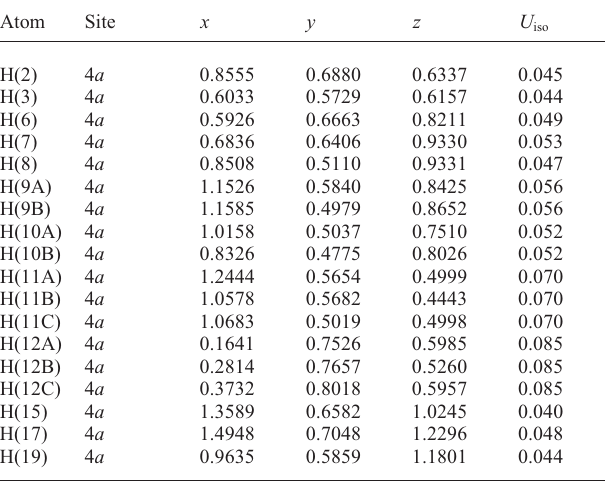
Table 2. Atomic coordinates and displacement parameters (in Å 2 )